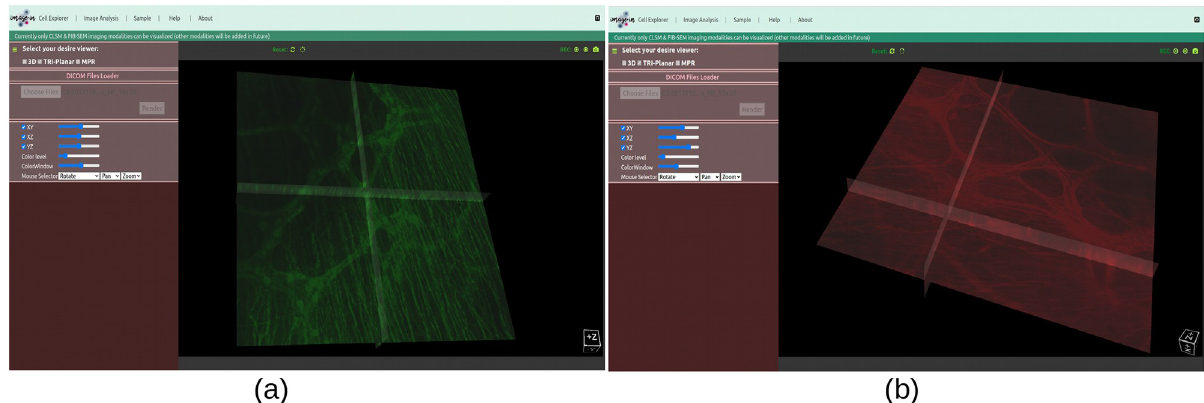
Fig 13. The two-channel mouse proximal colon [46] CLSM dataset is rendered into tri-planar viewer. (a) Channel-1: (green) neuronal nitric oxide synthase (nNOS) (b) Channel-2: (red) neurofilament (NF) heavy chain.